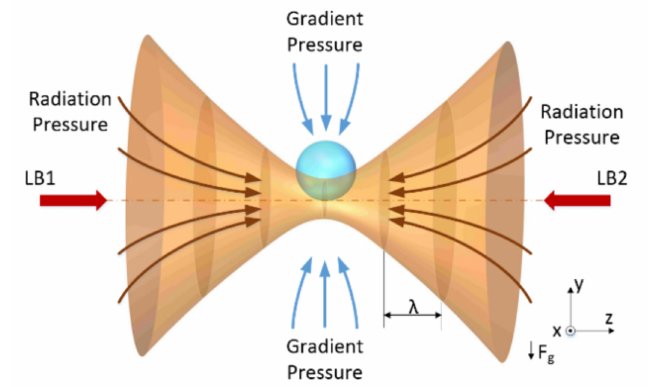
Figure 1. The dual-beam optical trap uses two strongly focused beams for trapping particles. The two beams named LB1 and LB2. The intensity gradients in the two converging beams draw particles toward the focus, whereas the radiation pressures of the two beams tend to blow them toward the optical axis. Under conditions where the two beams have the same intensity, the beams are coaxial and focused on the same point. A particle can be trapped in three dimensions, near the focal